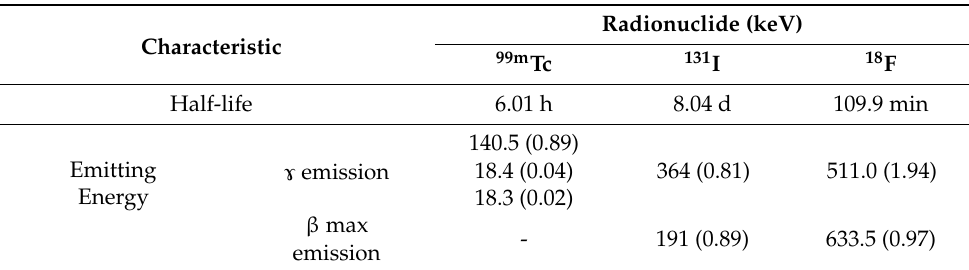
Figure 7. Description of the polymer encapsulation structure of tungsten particles.